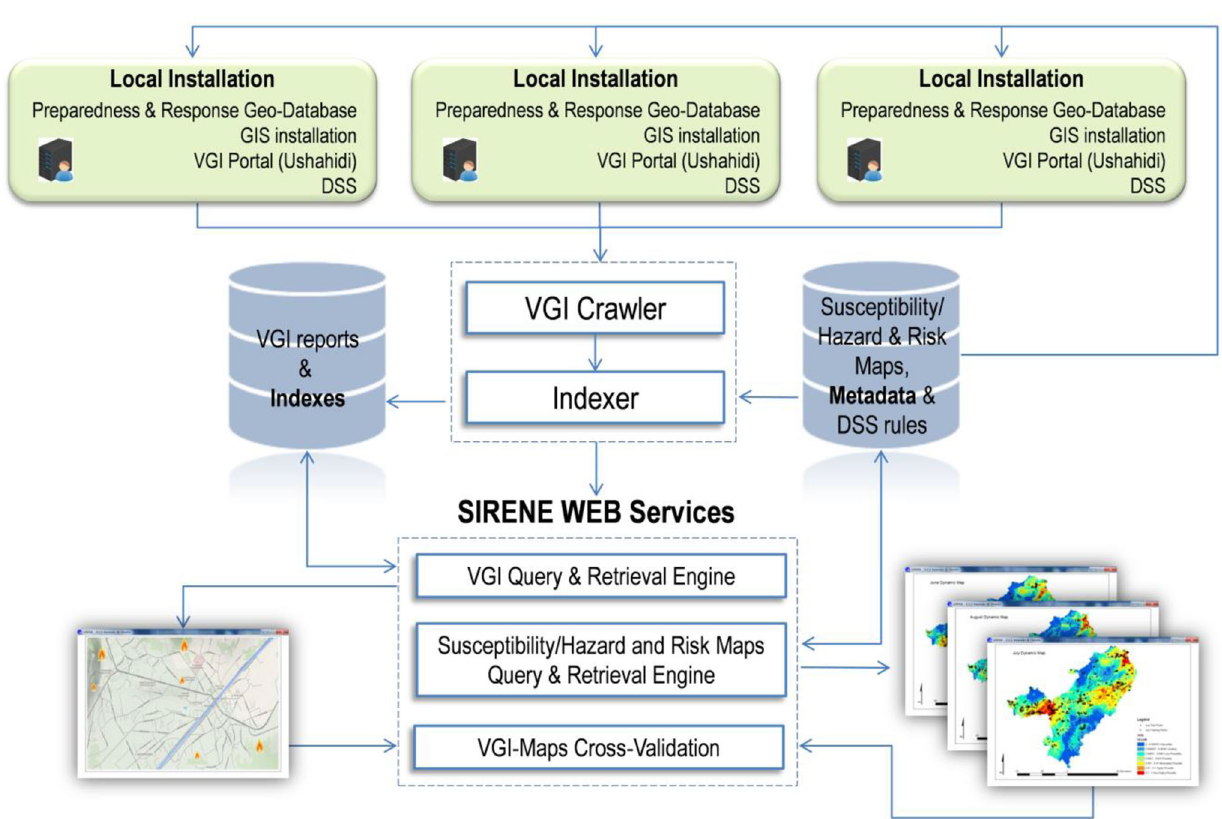
Fig. 1 Conceptual scheme of the distributed modules/services com- posing SIRENE. A minimal kernel installation of the Web services is hosted locally to allow disaster managers to cope with an emergency even when the Internet connection is not working. It includes: a data repository (Preparedness and Response Geo-Database), a GIS